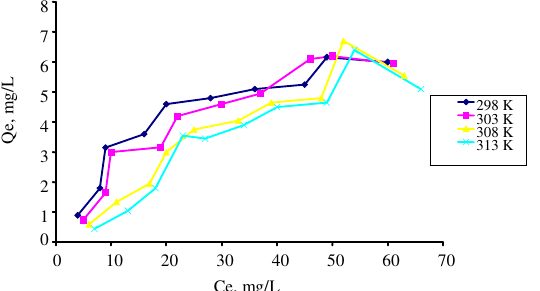
Figure 10. Effect of temperature on the adsorption capacity of dye B with charcoal at pH